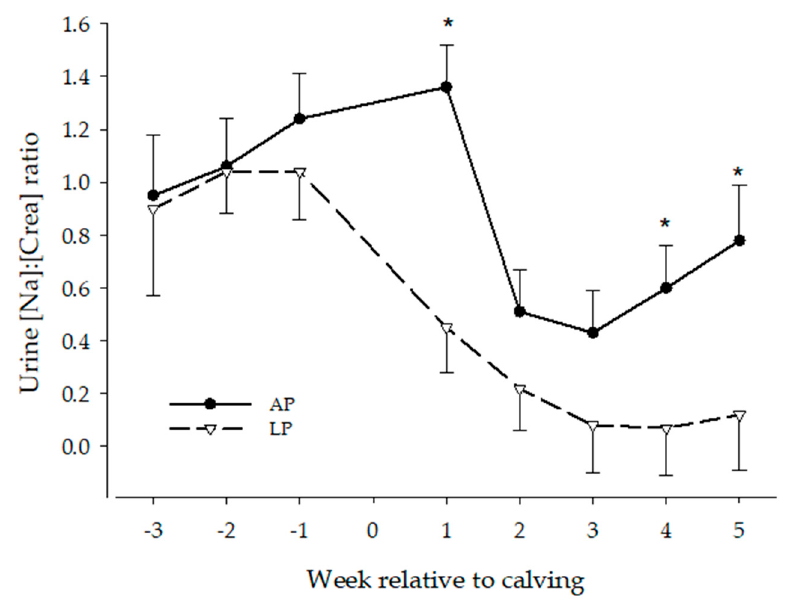
Figure 8. Urine Na:creatinine ratio of dairy cattle receiving either a P deficient diet (LP, n = 9) or a diet with adequate P content (AP, n = 9) in the periparturient period. * means significant different from other treatment at that time.